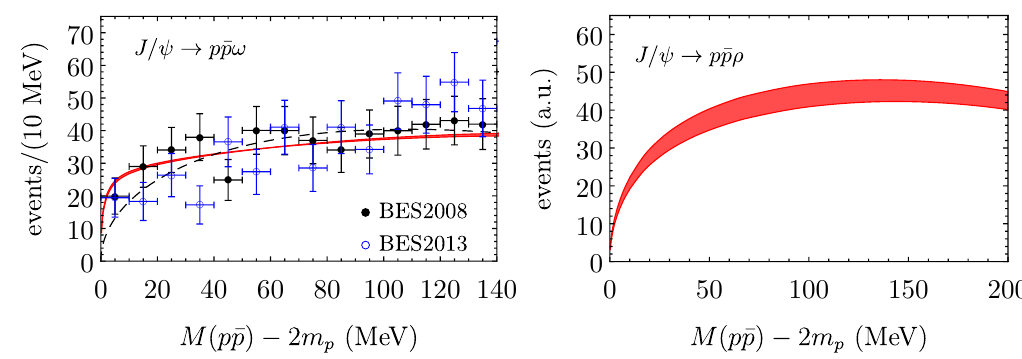
Figure 4. Left picture: J /ψ → p ¯ p ω decay; right picture: J /ψ → p ¯ p ρ decay. The phase space behavior is shown by the dashed curve.